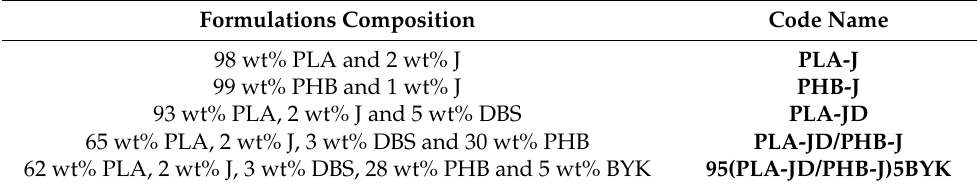
Figure 1. Scheme of PLA-Joncryl reaction to obtain possible long chain branching structures. Reprinted with permission from Ref. [33]. Copyright 2012 Elsevier B.V. Table 1. Formulation compositions with weight ratio and code name.